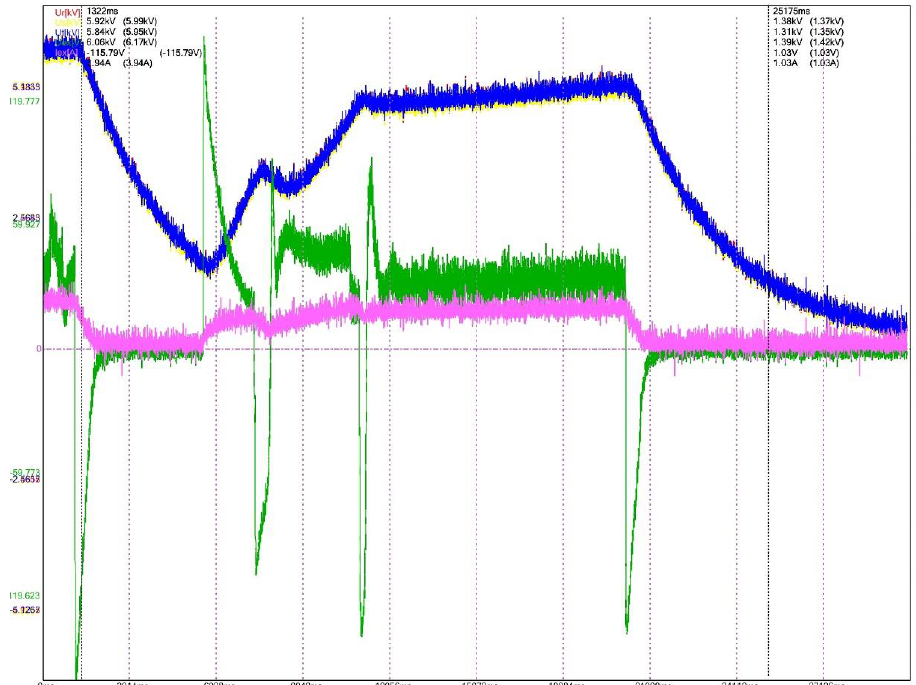
Figure 13. Power - off generator, CHE Dăești, Vâlcea.